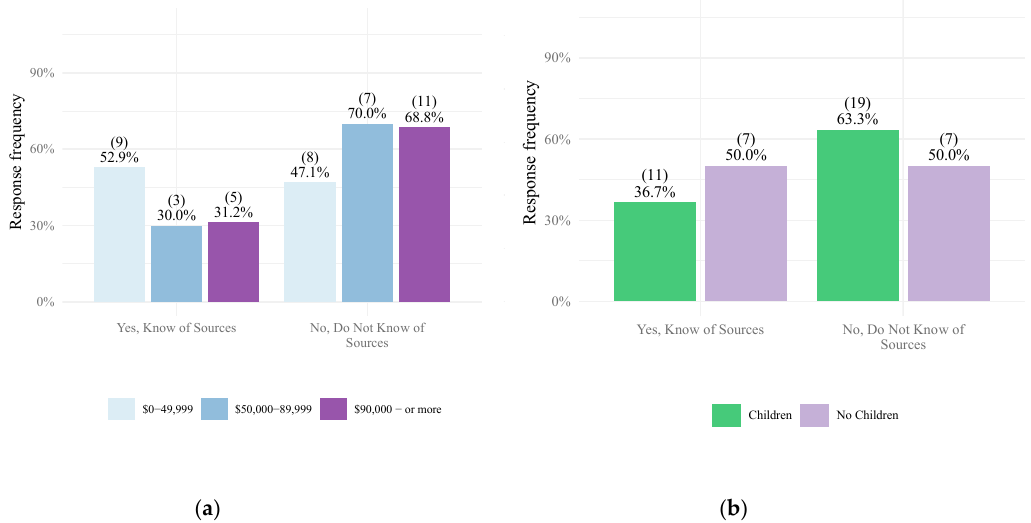
Figure A5. Knowledge of participants regarding potential soil remediation methods. Total question respondents: 41.